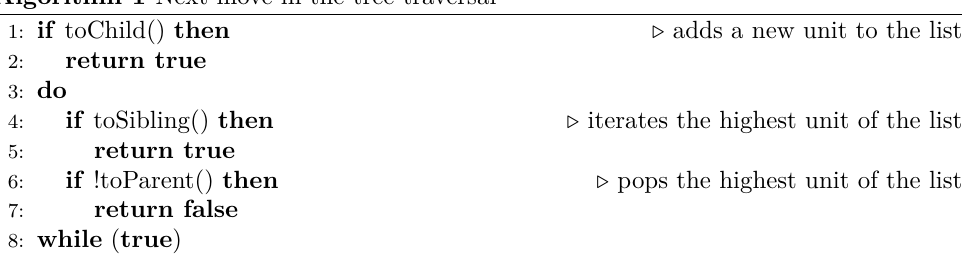
Algorithm 1 Next move in the tree